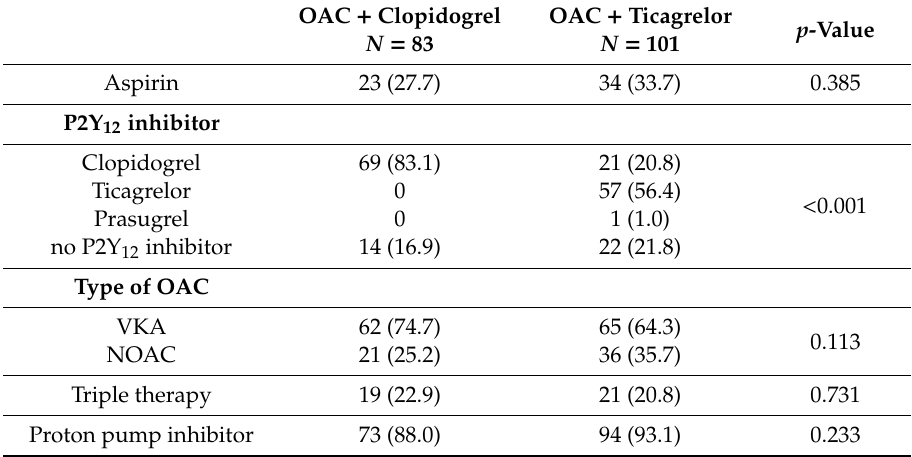
Table 2. Medication at